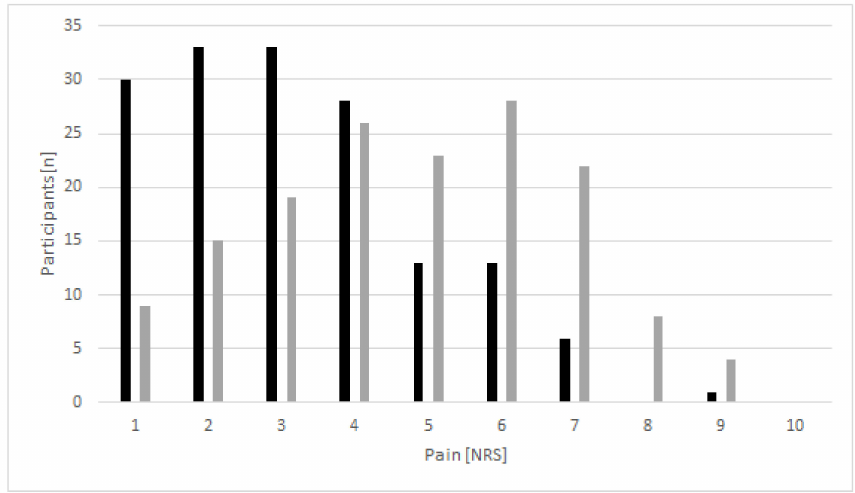
Figure 4. Distribution of pain intensity in race participants reporting discomfort ( n = 158) at rest (black bars) and during activity (grey bars).